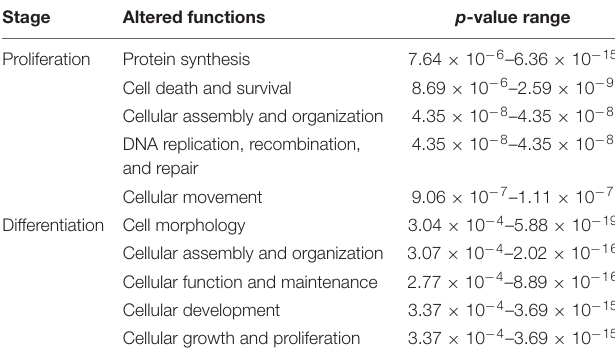
TABLE 3 | Top five altered molecular and cellular functions affected by DAP knockdown in proliferating and differentiating satellite cells.